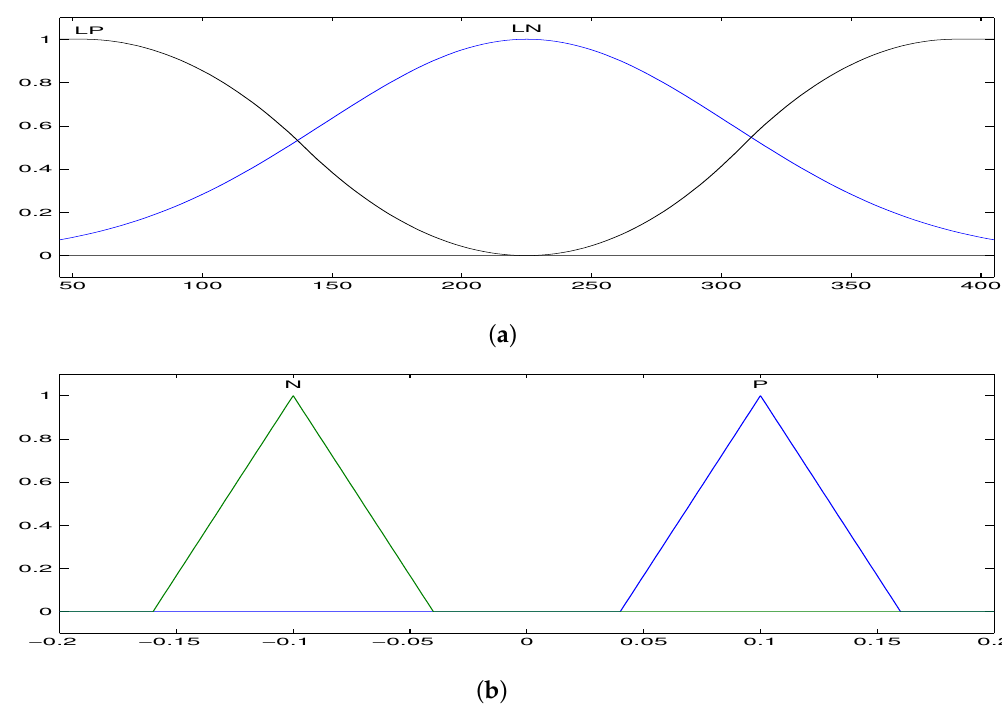
Figure 8. ( a ) Input membership functions for first PF controller; ( b ) output membership functions for first PF controller.